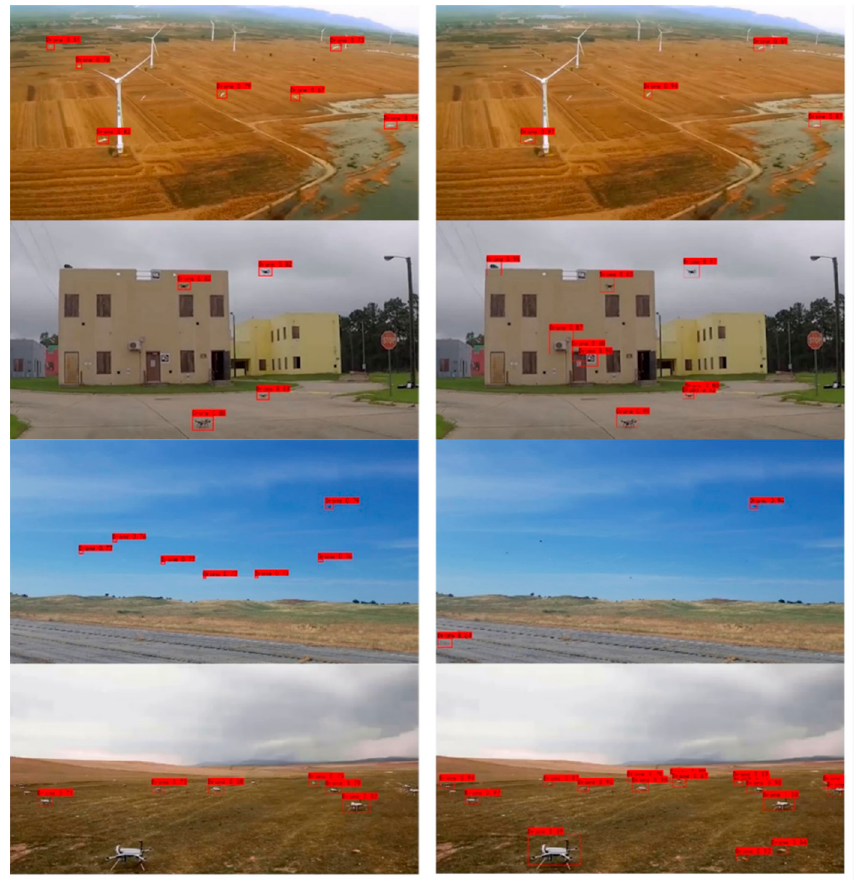
Figure 6. Sample visualization results images of the testing sequence (Right: Faster R-CNN; Left: YOLOX).